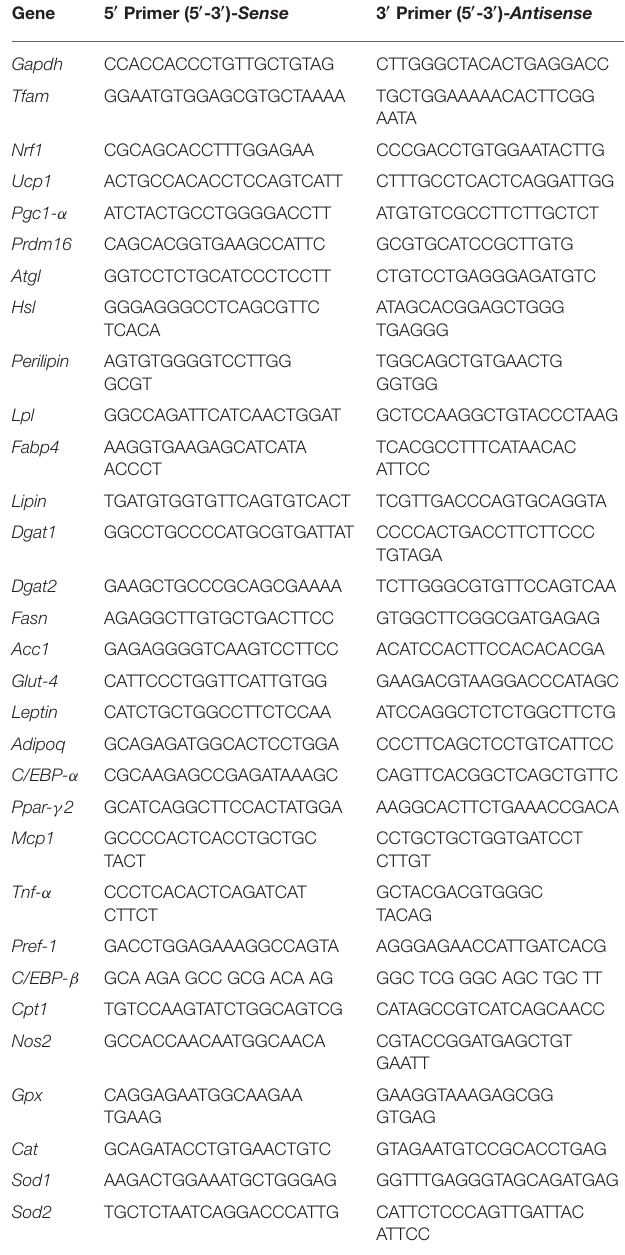
TABLE 1 | Sense e antisense primers sequences used for real-time quantitative PCR.